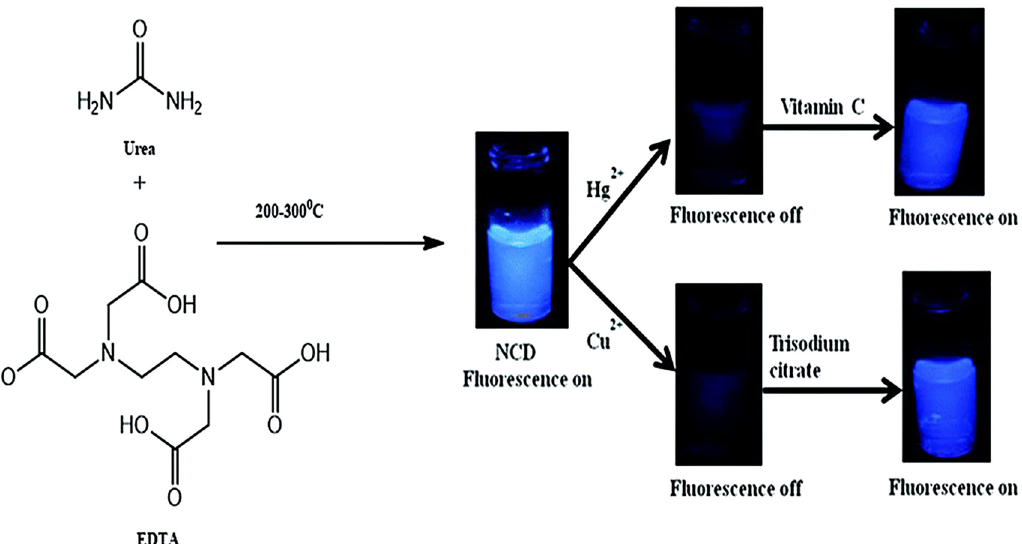
Figure4: SimultaneouslysensingofCu(II)andHg(II)byfluorescenceON – OFF – ONprocesswiththeadditionofrestorationreagents.Reprinted from Zhao et al. ’ s work with the kind permission of The Royal Society of Chemistry [108]. Copyright (2019) The Royal Society of